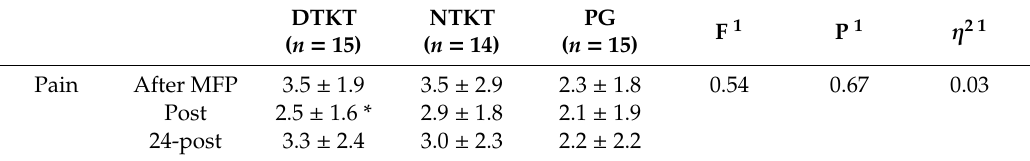
Table 2. Subjective pain changes after intervention in the three groups ( N =